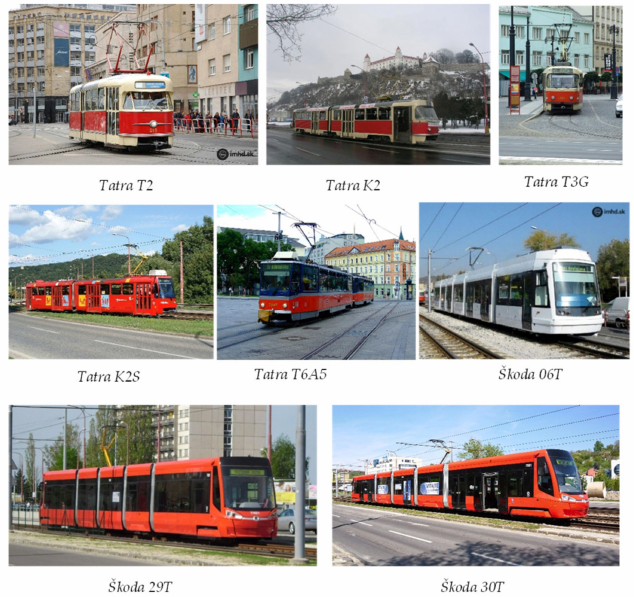
Figure 1. Currently operated tram vehicles in Bratislava